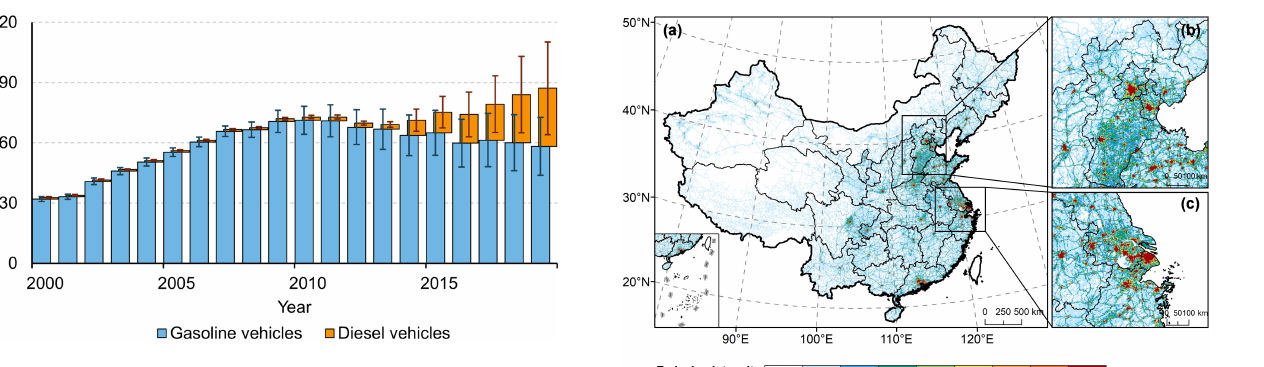
Figure 2. Annual vehicular NH 3 emissions by fuel type in China with uncertainty ranges, 2000–2019.